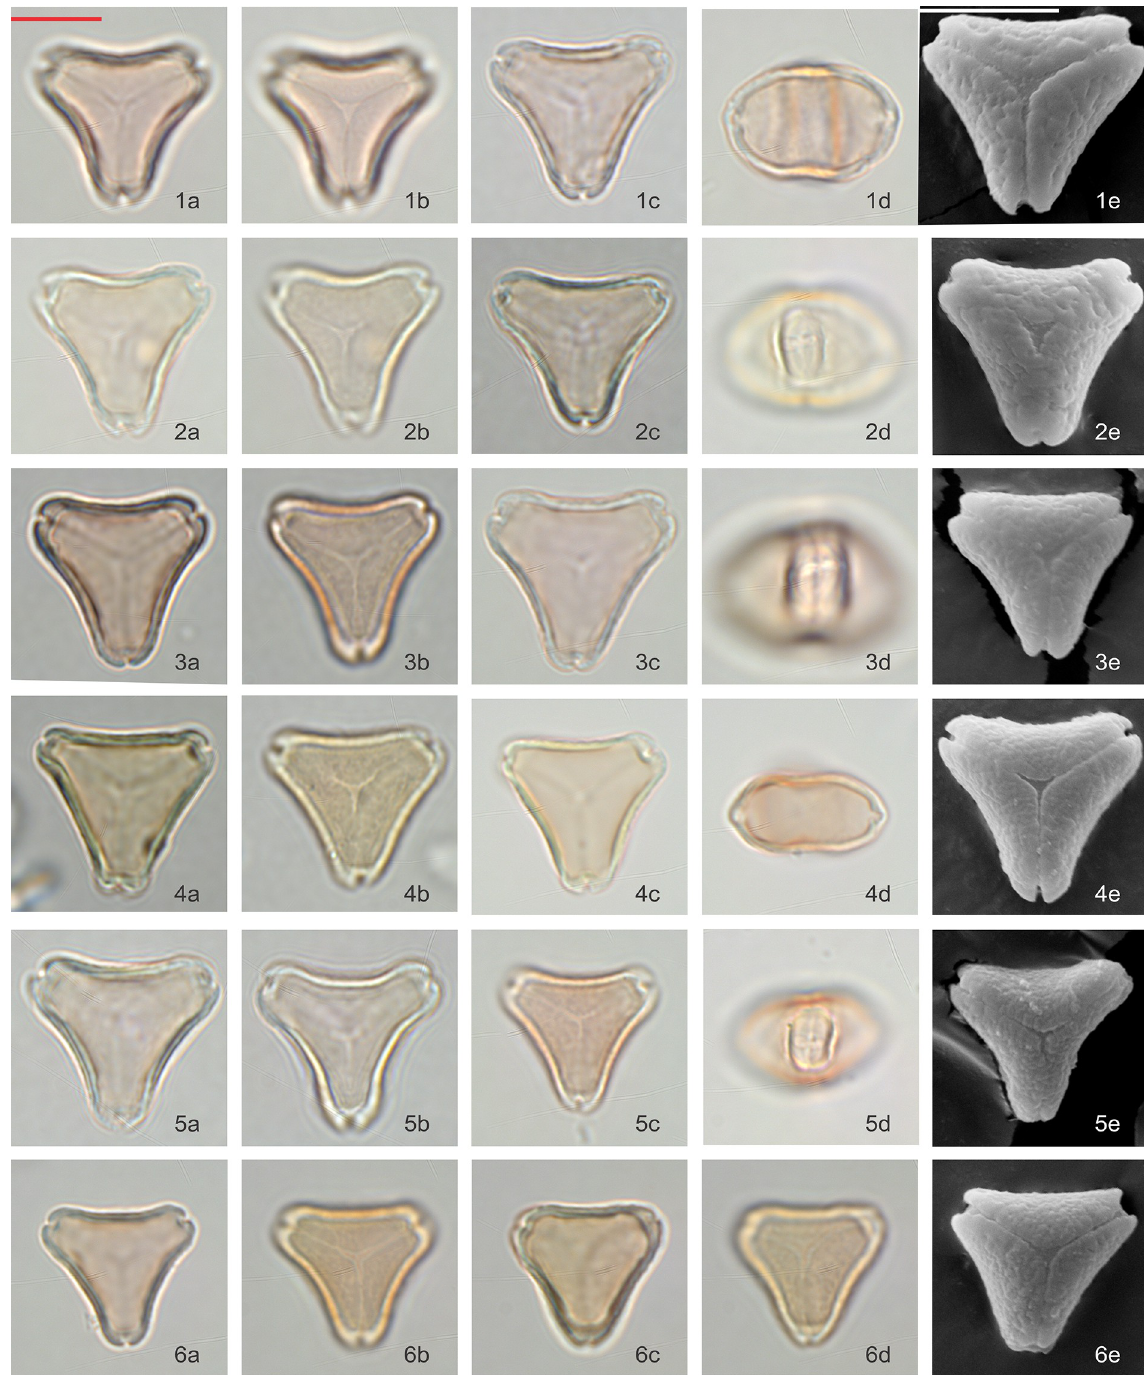
Fig 4. Polar and equatorial views of Leptospermum scoparium , Part 2. Scale bar = 10 μ m. (1a-1e) South Island Mountain, (2a-2e) Central Volcanic Plateau, (3a-3e) L . scoparium var. incanum , (4a-4e) Three Kings, (5a-5e, 6a-6e) Auckland.